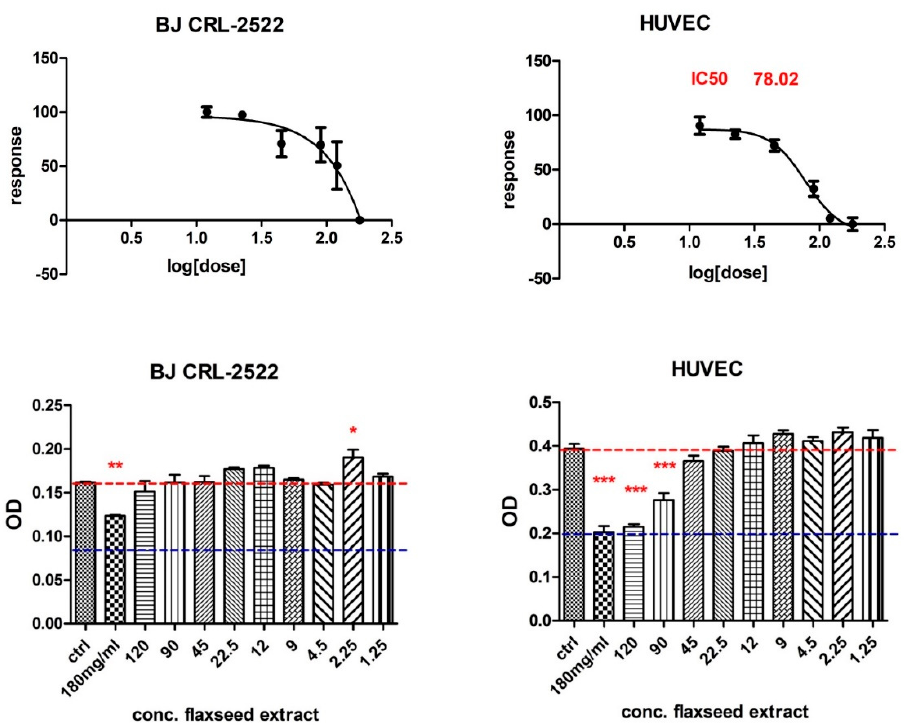
Figure 5. MTT assay results of BJ fibroblasts cells and HUVEC cells treated with different concentrations of flaxseed extract, where p ≤ 0.05 (*), p ≤ 0.01 (**), and p ≤ 0.001 (***) as compared with control.